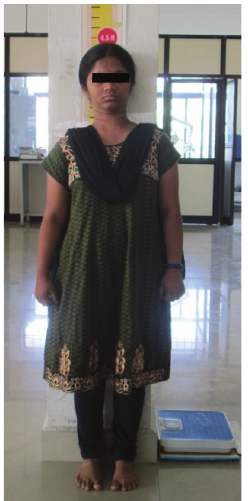
Figure 3: Extraoral photographs.